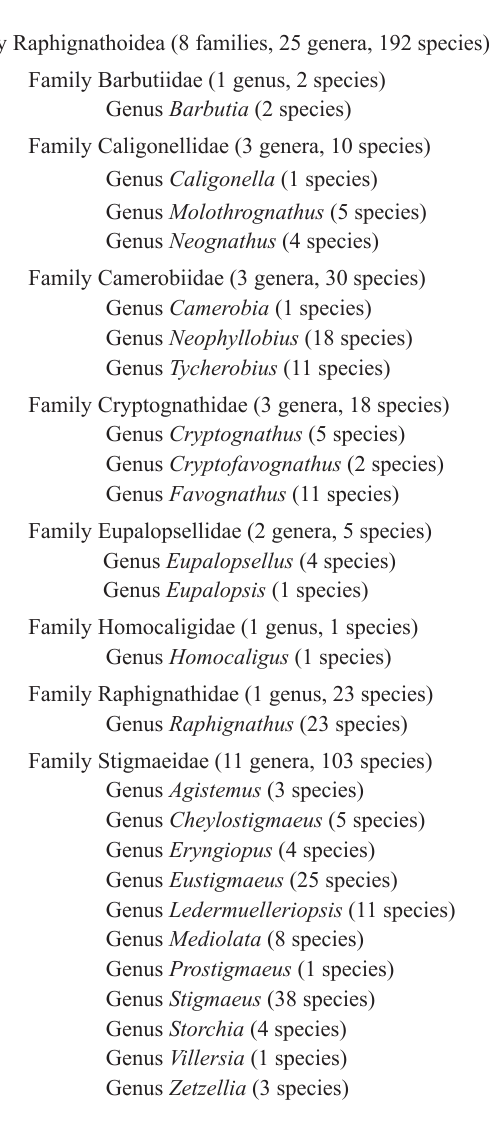
Table 2. The number of raphignathoid mite species known from